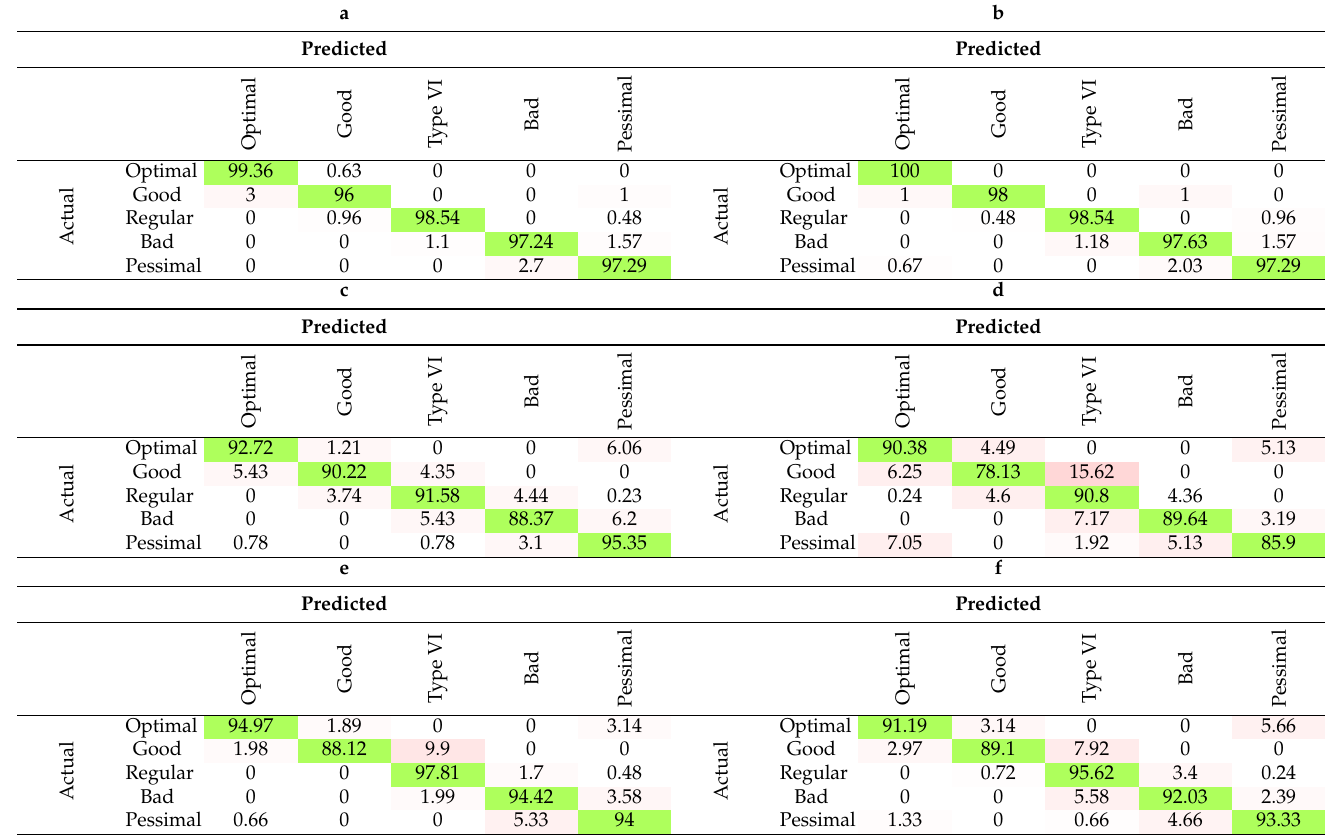
Table 6. Confusion matrix results for the ( a ) first neural network, ( b ) second neural network, ( c ) KNN, ( d ) Bayesian network, ( e ) support vector machines, and ( f ) random forest